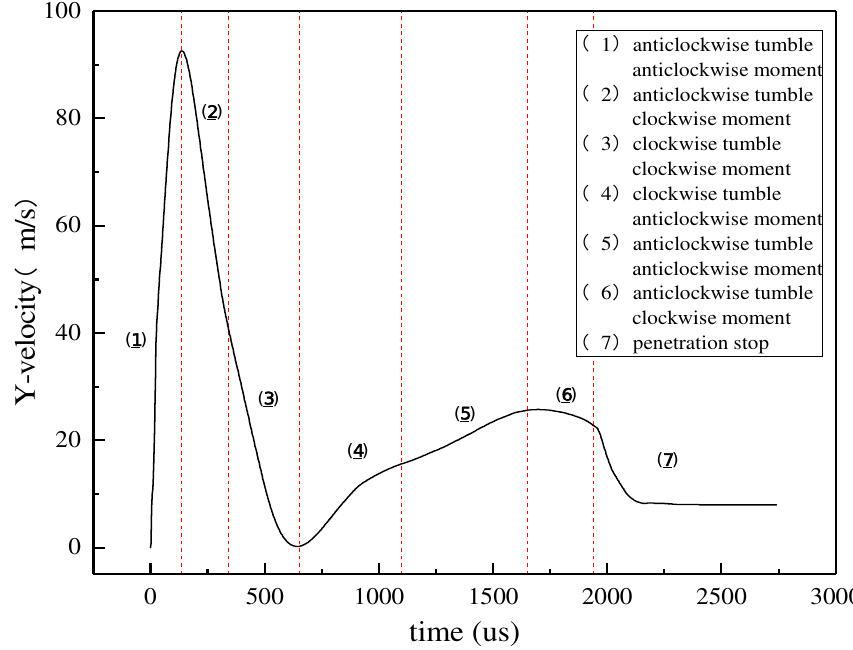
Figure 10. Y-axis velocity curve of projectile. (The red dash line is the dividing line of different stages)